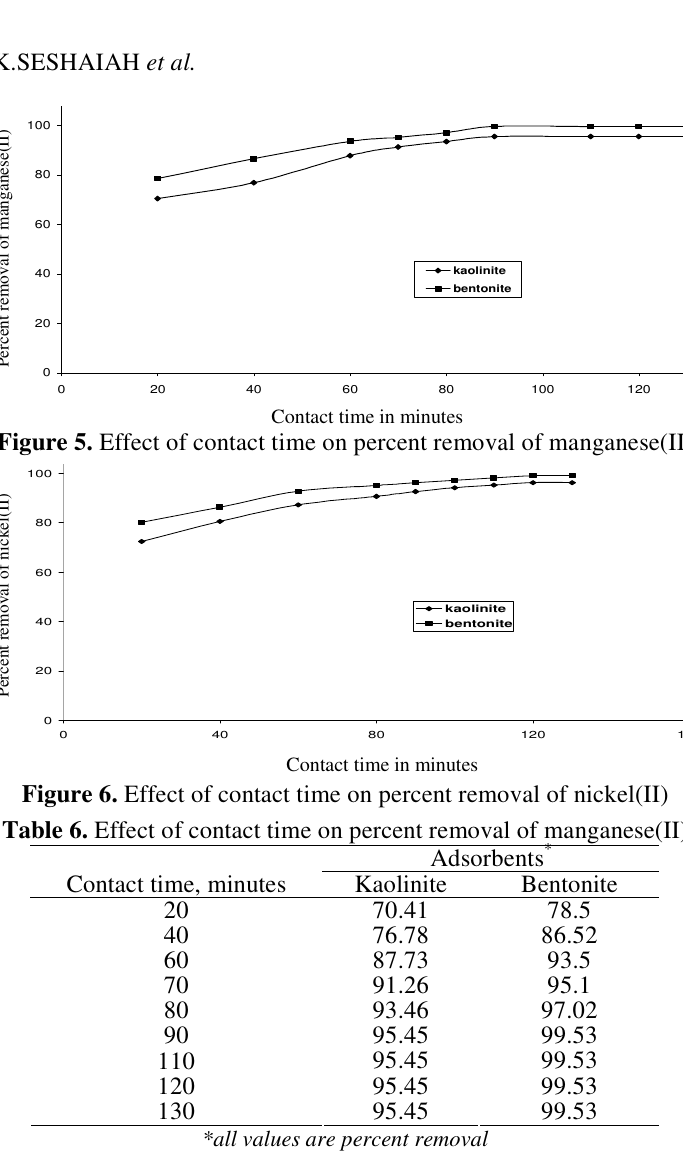
Table 7. Effect of contact time on percent removal of nickel(II) Contact time, min Kaolinite Bentonite